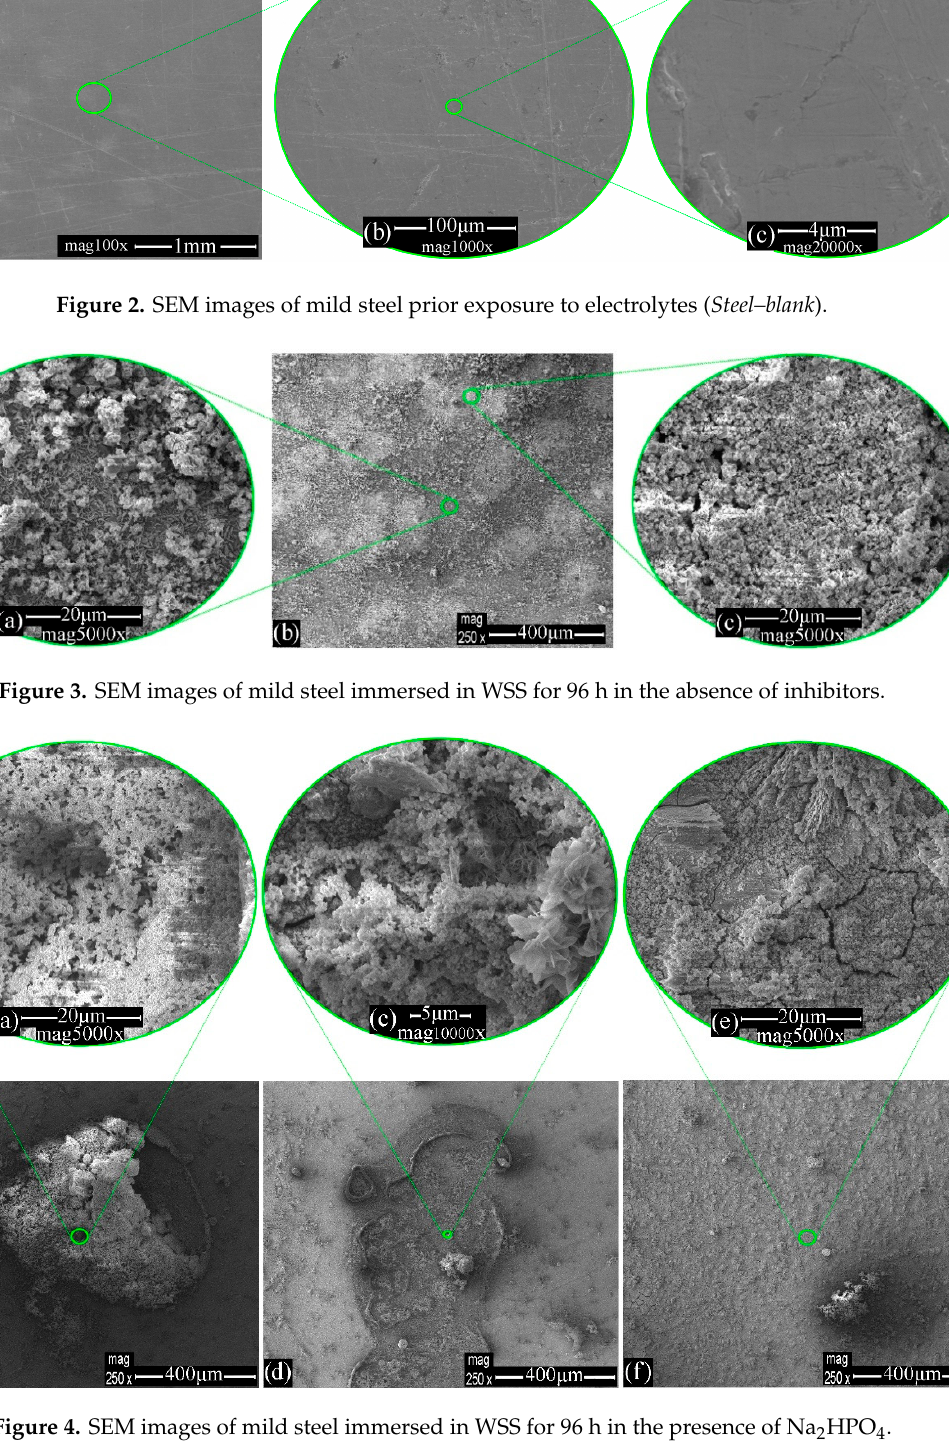
Figure 4. SEM images of mild steel immersed in WSS for 96 h in the presence of Na 2 HPO 4